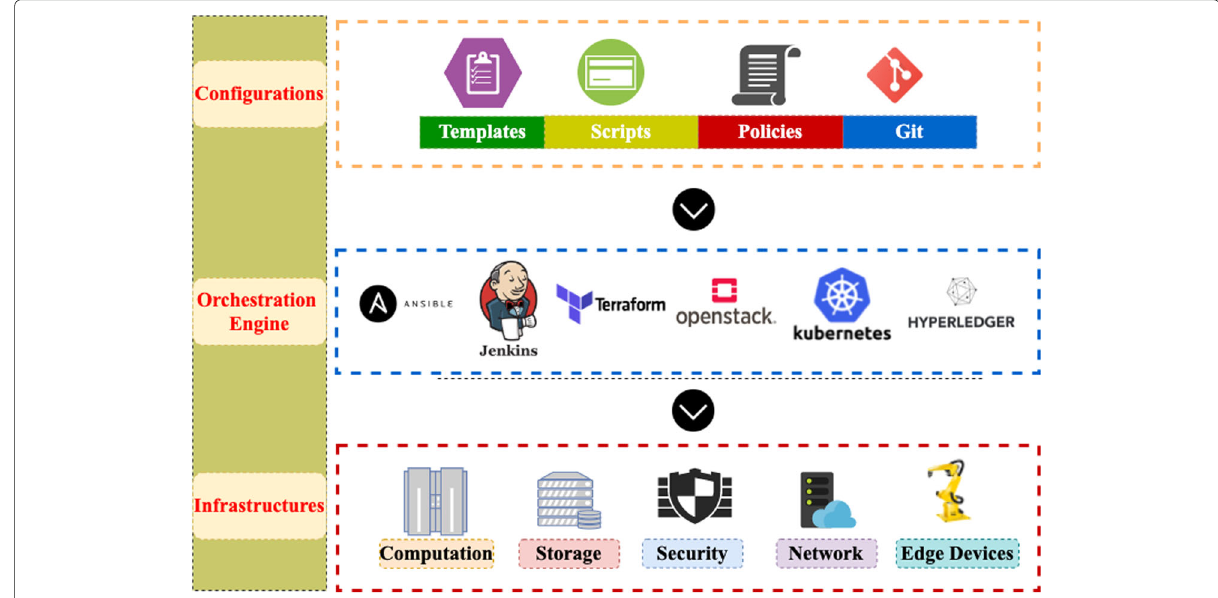
Fig. 4 IaC Service Platform design: Membership and virtualized